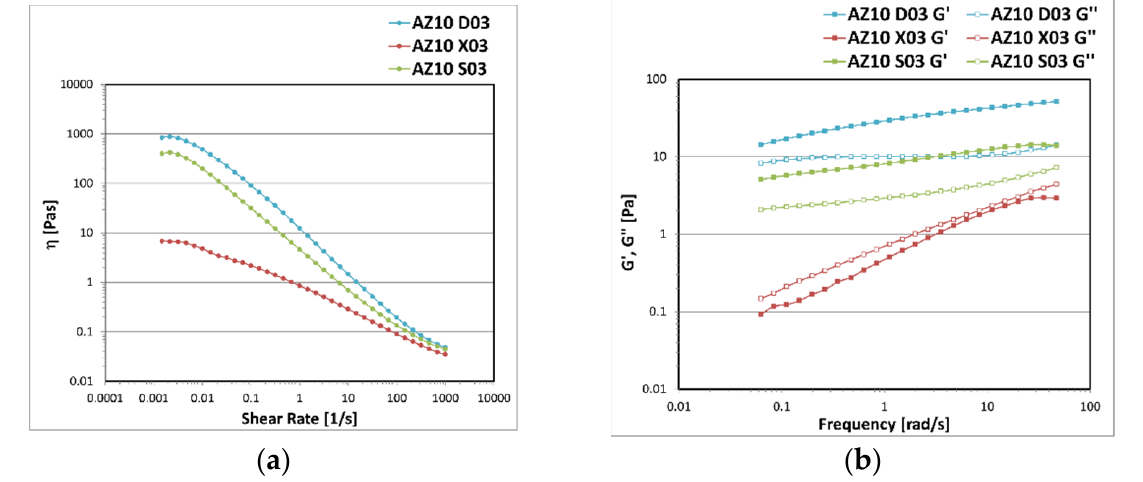
Figure 2. Viscosity trend as a function of shear rate ( a ) and storage G’ and loss G’’ moduli trend as a function of frequency ( b ) measured for the emulsions prepared with A-Z associations (1:1) and the polysaccharides D, X, and S at 0.3% w/w.